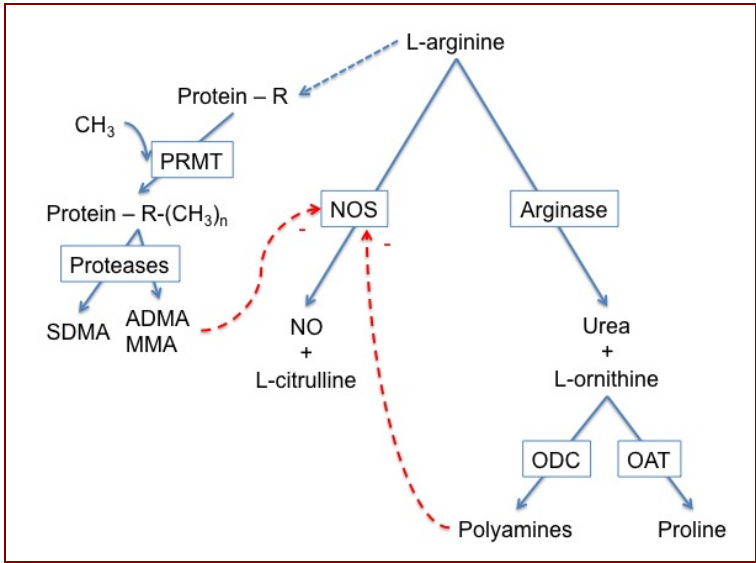
Figure 1. Schema of L -arginine metabolism via the NO synthase (NOS) and arginase pathways to nitric oxide (NO) and L -citrulline, and urea and L -ornithine, respectively. L -Ornithine is metabolized by ornithine decarboxylase (ODC) to polyamines, which can block NOS activity, or by ornithine aminotransferase (OAT), which provides proline, a precursor of collagen biosynthesis. L -Arginine is also incorporated into proteins, where it can be mono- or di-methylated by protein arginine methyltransferases (PRMT), allowing the liberation of monomethyl arginine (MMA) and asymmetric dimethylarginine (ADMA) during proteolysis, which act as endogenous inhibitors of NOS, as well as symmetric dimethylarginine (SDMA), which competes with L -arginine for uptake by the cationic amino acid transporter-2